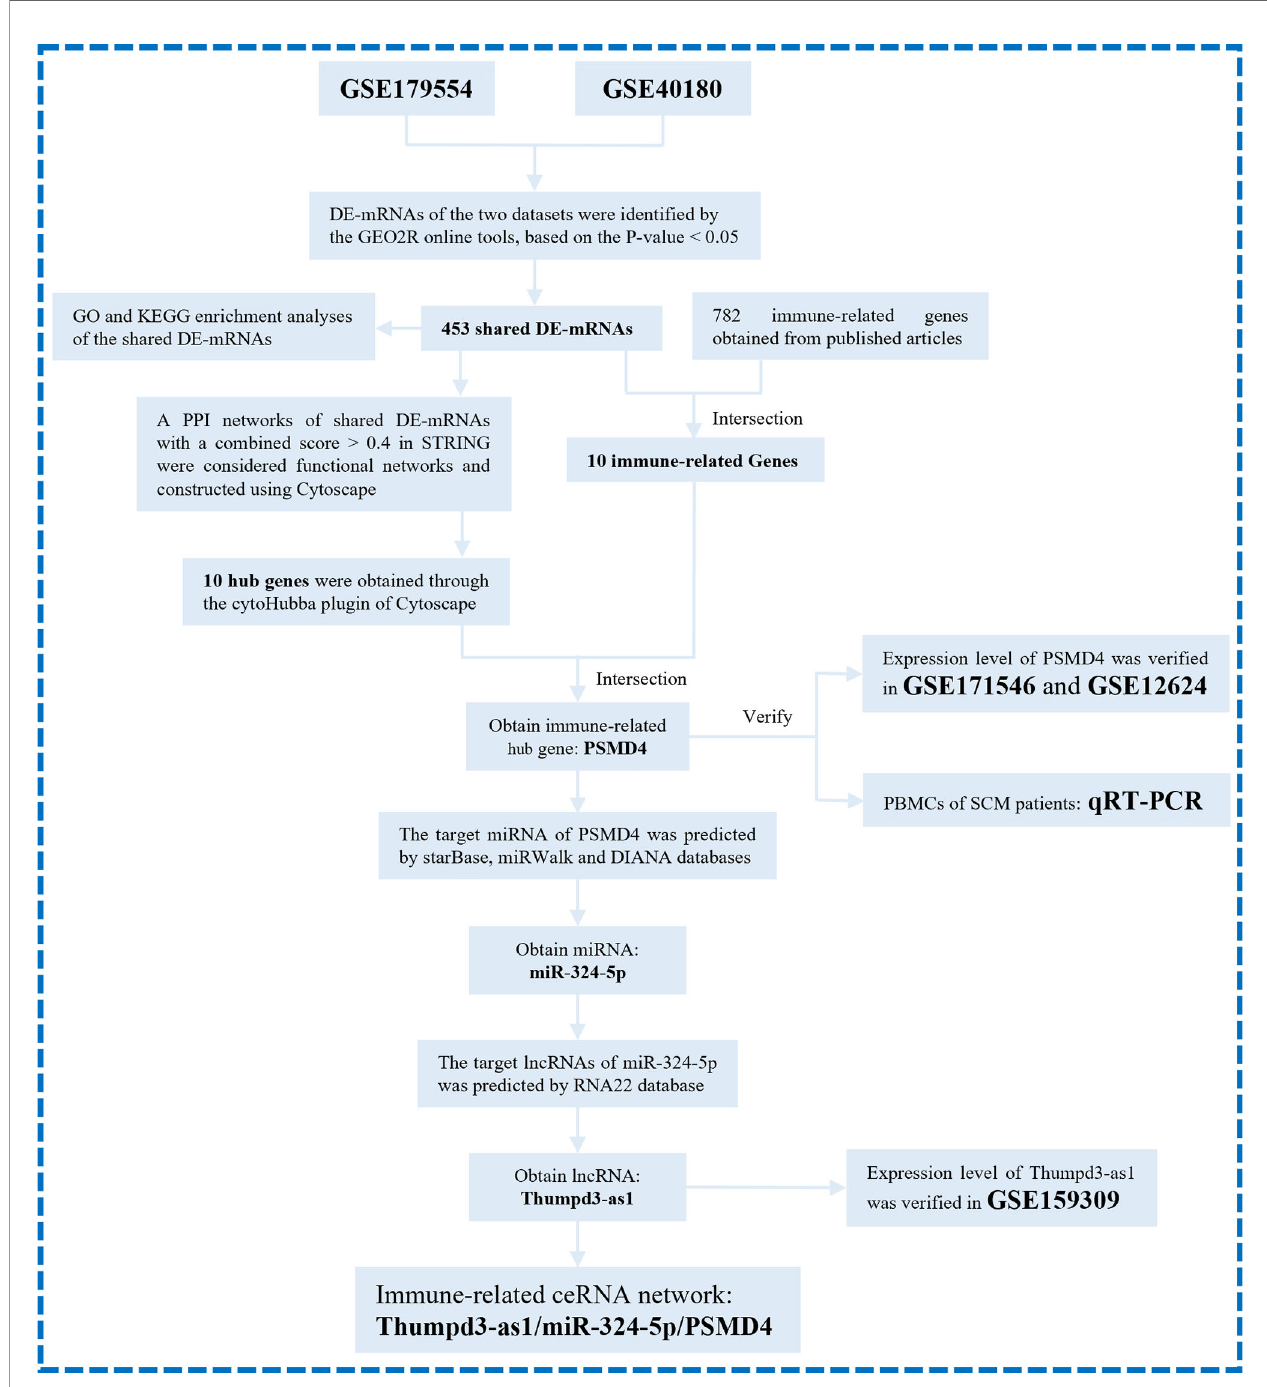
FIGURE 1 | The overall protocol of this study. DE-mRNAs, differentially expressed mRNAs; GO, Gene Ontology; KEGG, Kyoto Encyclopedia Genes and Genomes; PPI, protein – protein